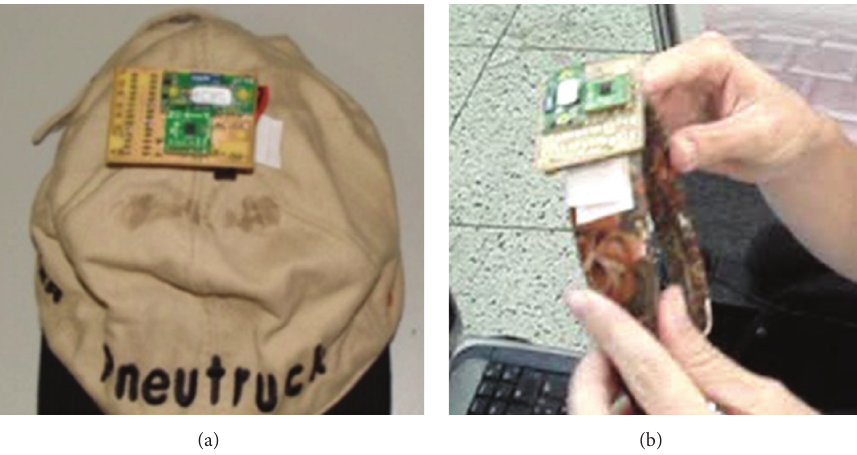
Figure 4: Inertial sensor mounted on a cap or headband. These two accessories were proposed to provide comfort to the user’s tastes.